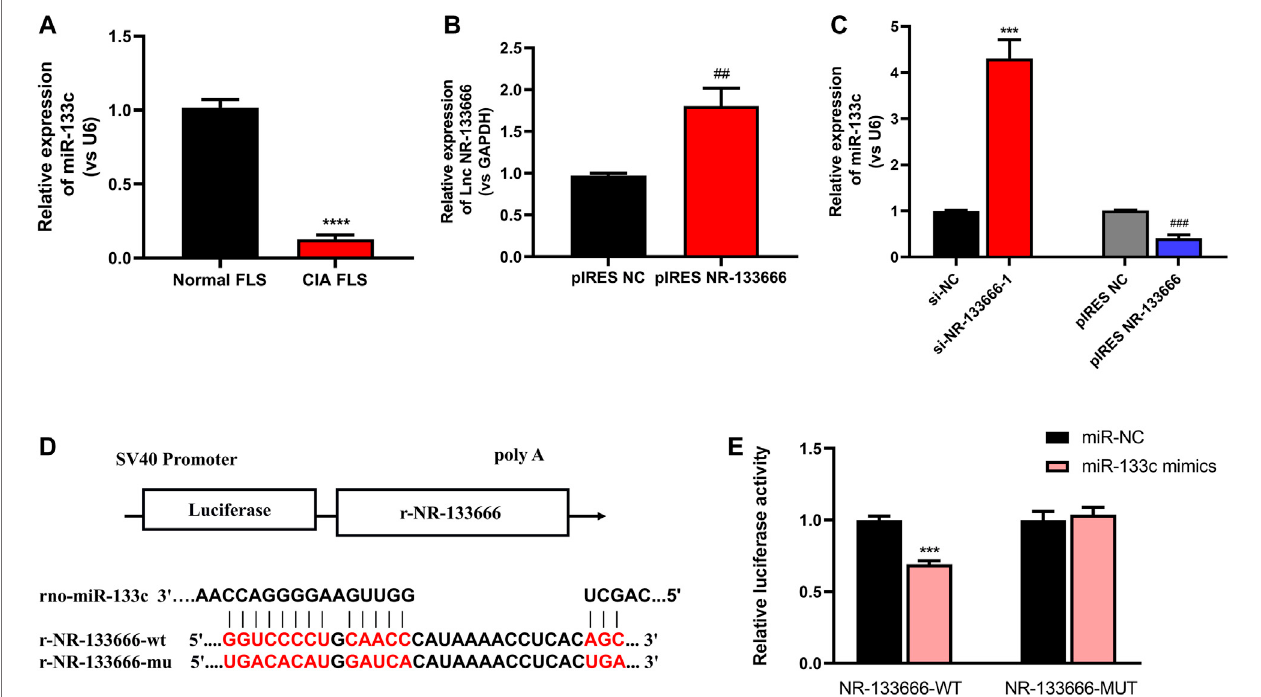
FIGURE4| lncRNANR-133666 behaves likeasponge formiR-133c. (A) qRT-PCRshowed thatmiR-133c wasincreased inCIA FLS. (B) qRT-PCR showed that NR-133666 was increased in pIRES NR-133666-transfected CIA FLS. (C) The expression of miR-133c in si-NR-133666 – 1 and pIRES NR-133666 groups. (D) The predicted binding site between miR-133c and NR-133666. (E) Co-transfection of lncRNA NR-133666 WT and miR-133c mimics decreased luciferase activity. Compared with controls, *** p < 0.001, **** p < 0.0001; compared with pIRES NC, ## p < 0.01, ### p < 0.001.